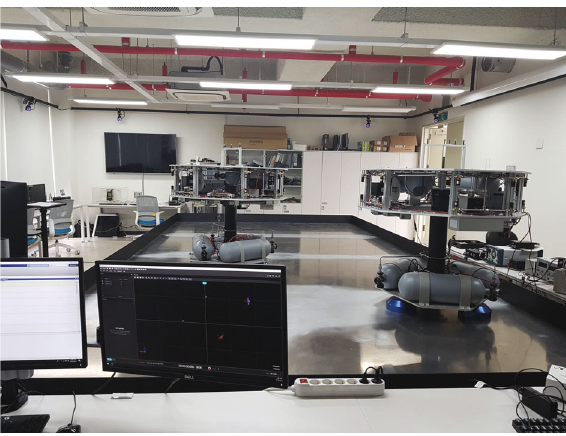
Figure 1: The testbed facility: